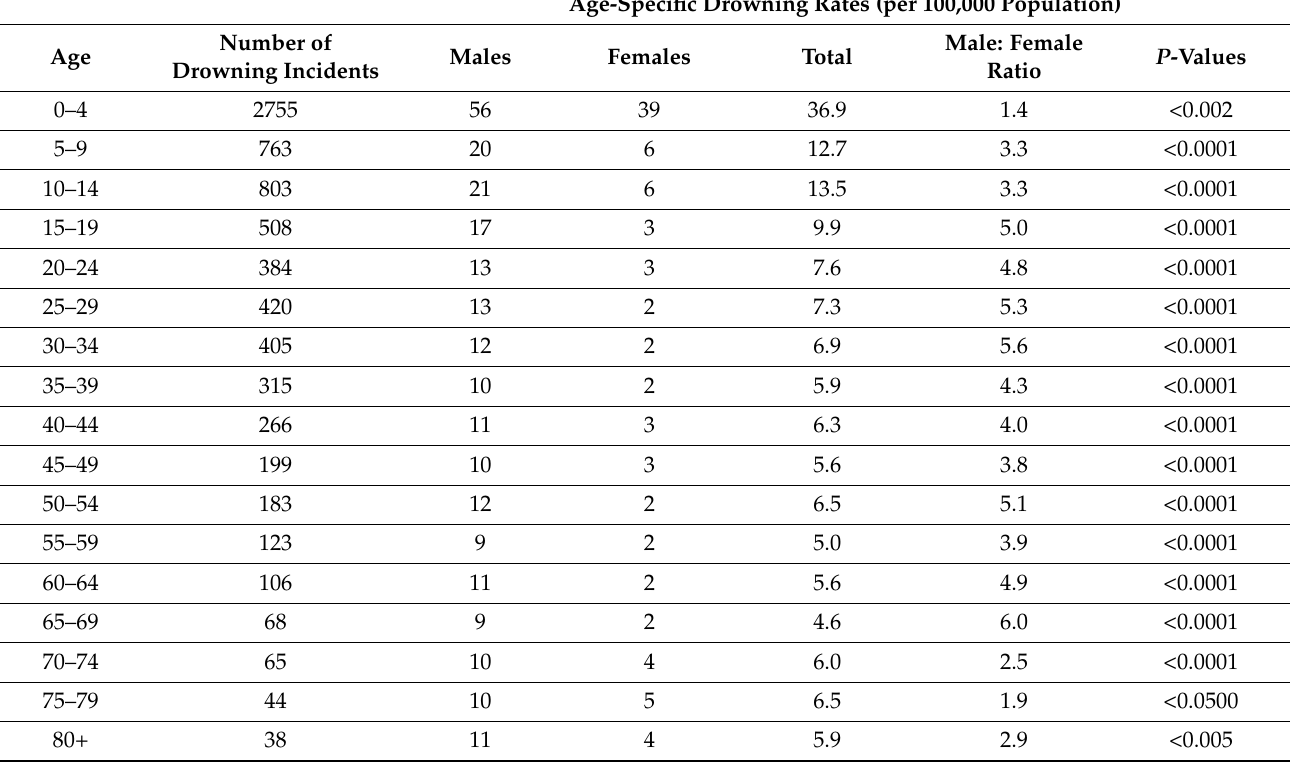
Table 2. Sex- and age-specific drowning rates in South Africa,